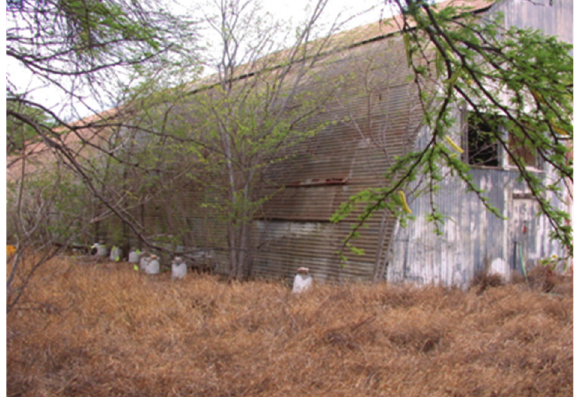
Figure 2: Coptotermes gestroi field site at Kalaeloa, Oahu, Hawaii.